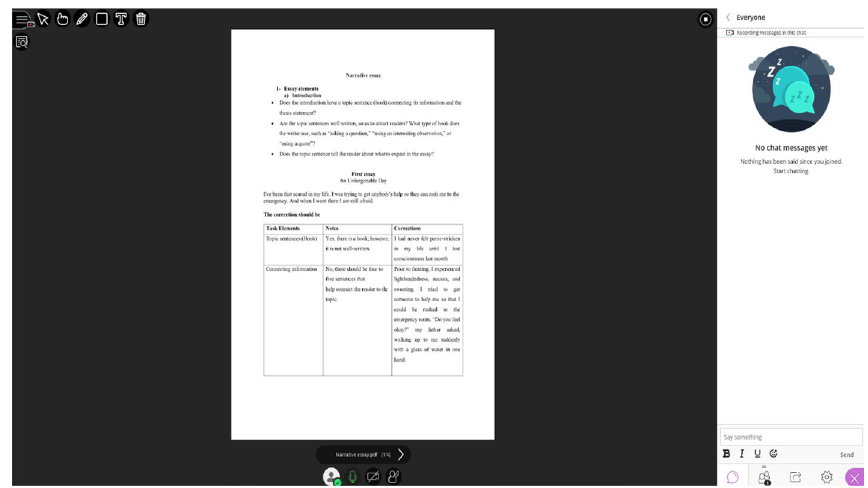
Fig. 2 A screenshot of the recording